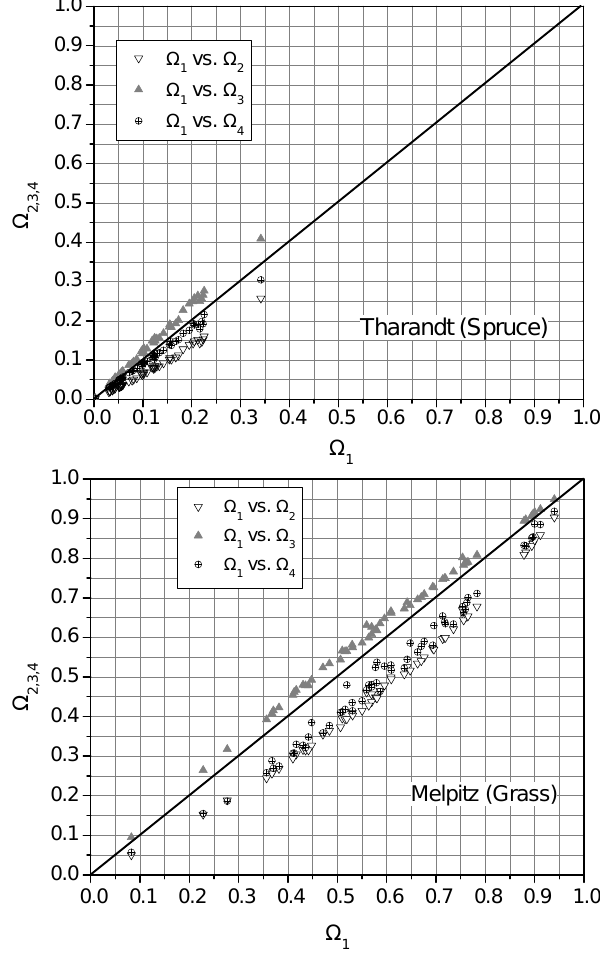
Fig. 9. Comparison of omega calculations for the Anchor Station Tharandt (panel above) and the Melpitz experimental site (panel below) for the investigation period 18 to 21 June 2000 (half-hour means from 09:00 to 16:00LT).